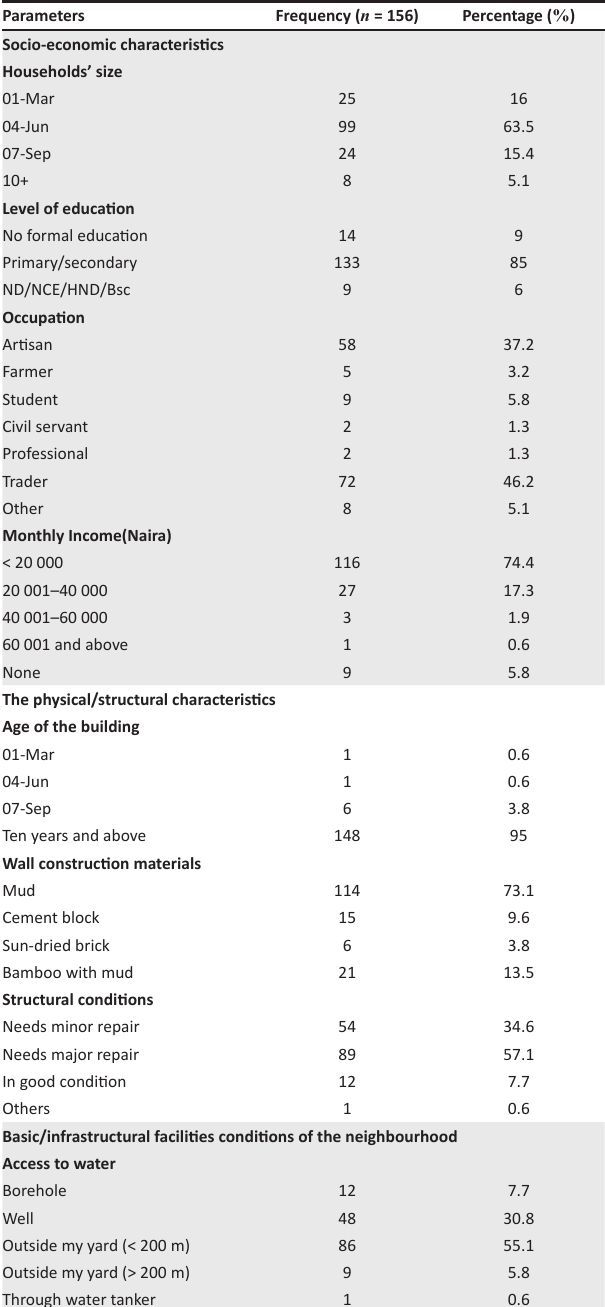
TABLE 3: Socio-economic, physical/structural and basic/infrastructural characteristics of households in Bere community. Parameters